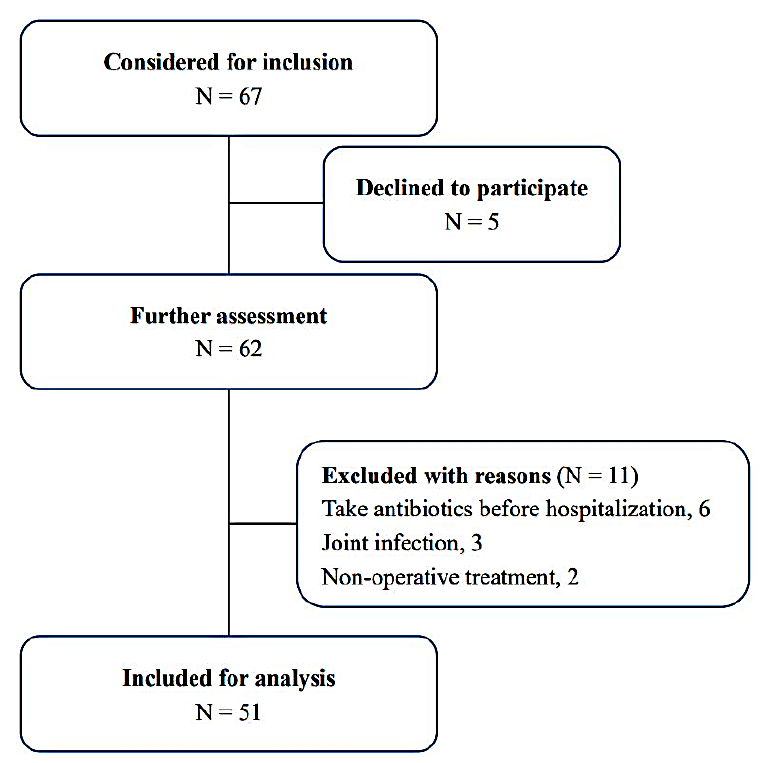
Figure 2. Eligibility selection process of the OM patients in this study. Table 1. Clinical features of the included OM patients, culture outcomes, and culture time by BSC and